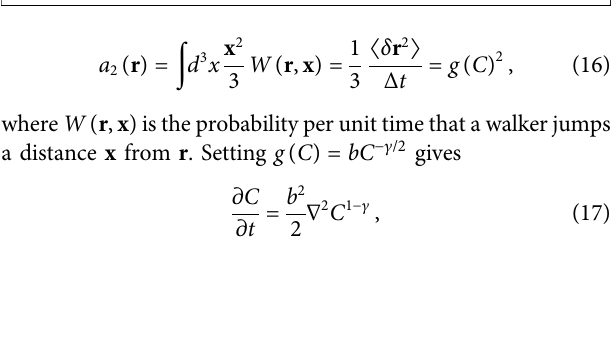
FIGURE 4 | Projections into the xy-plane of particle trajectories for differentvaluesof γ ,usingthein fi nite-interaction-rangemodel.Thelast10time steps are shown in black the last step in red. All simulations are run for a time t (cid:1) 10 with N p (cid:1) 500 particles, dt (cid:1) 1 / N c P , and D 0 (cid:1)